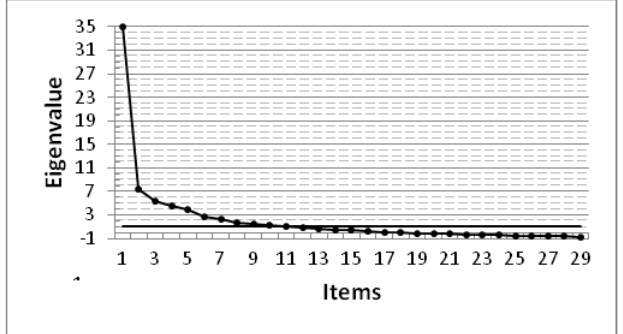
Figure 1: Maximum likelihood scree plot for 29 items